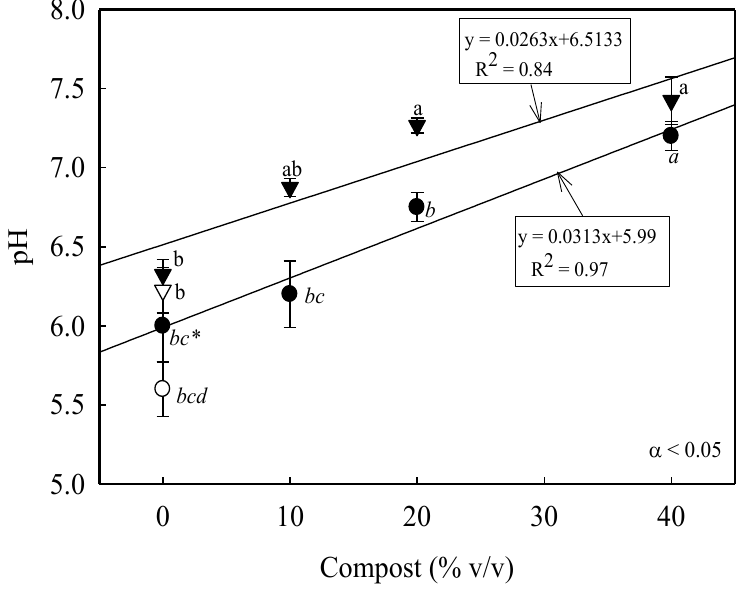
Figure 5. Effect of incorporating composted poultry litter into top 12.7 cm of subsoil on soil pH for ● sodded compost; ○ sodded fertilizer; ▼ seeded compost; and seeded fertilizer plots; * Means with same letters are statistically insignificant based on Fisher’s Protected LSD test ( P ≤ 0.05) (italicized statistics correspond to sodded